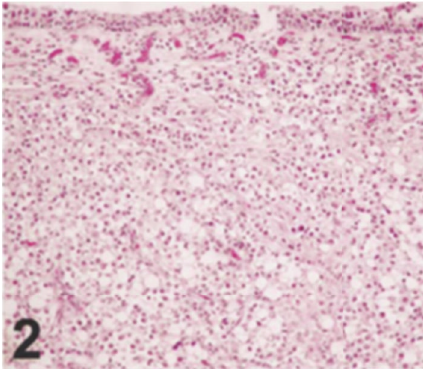
Figure 6: The neoplastic cells form ill-defined nests with a dif- fuse growth pattern. Some tumor cells have clear cytoplasm. The surface mucosa is not involved by the underlying tumor (Case 1)